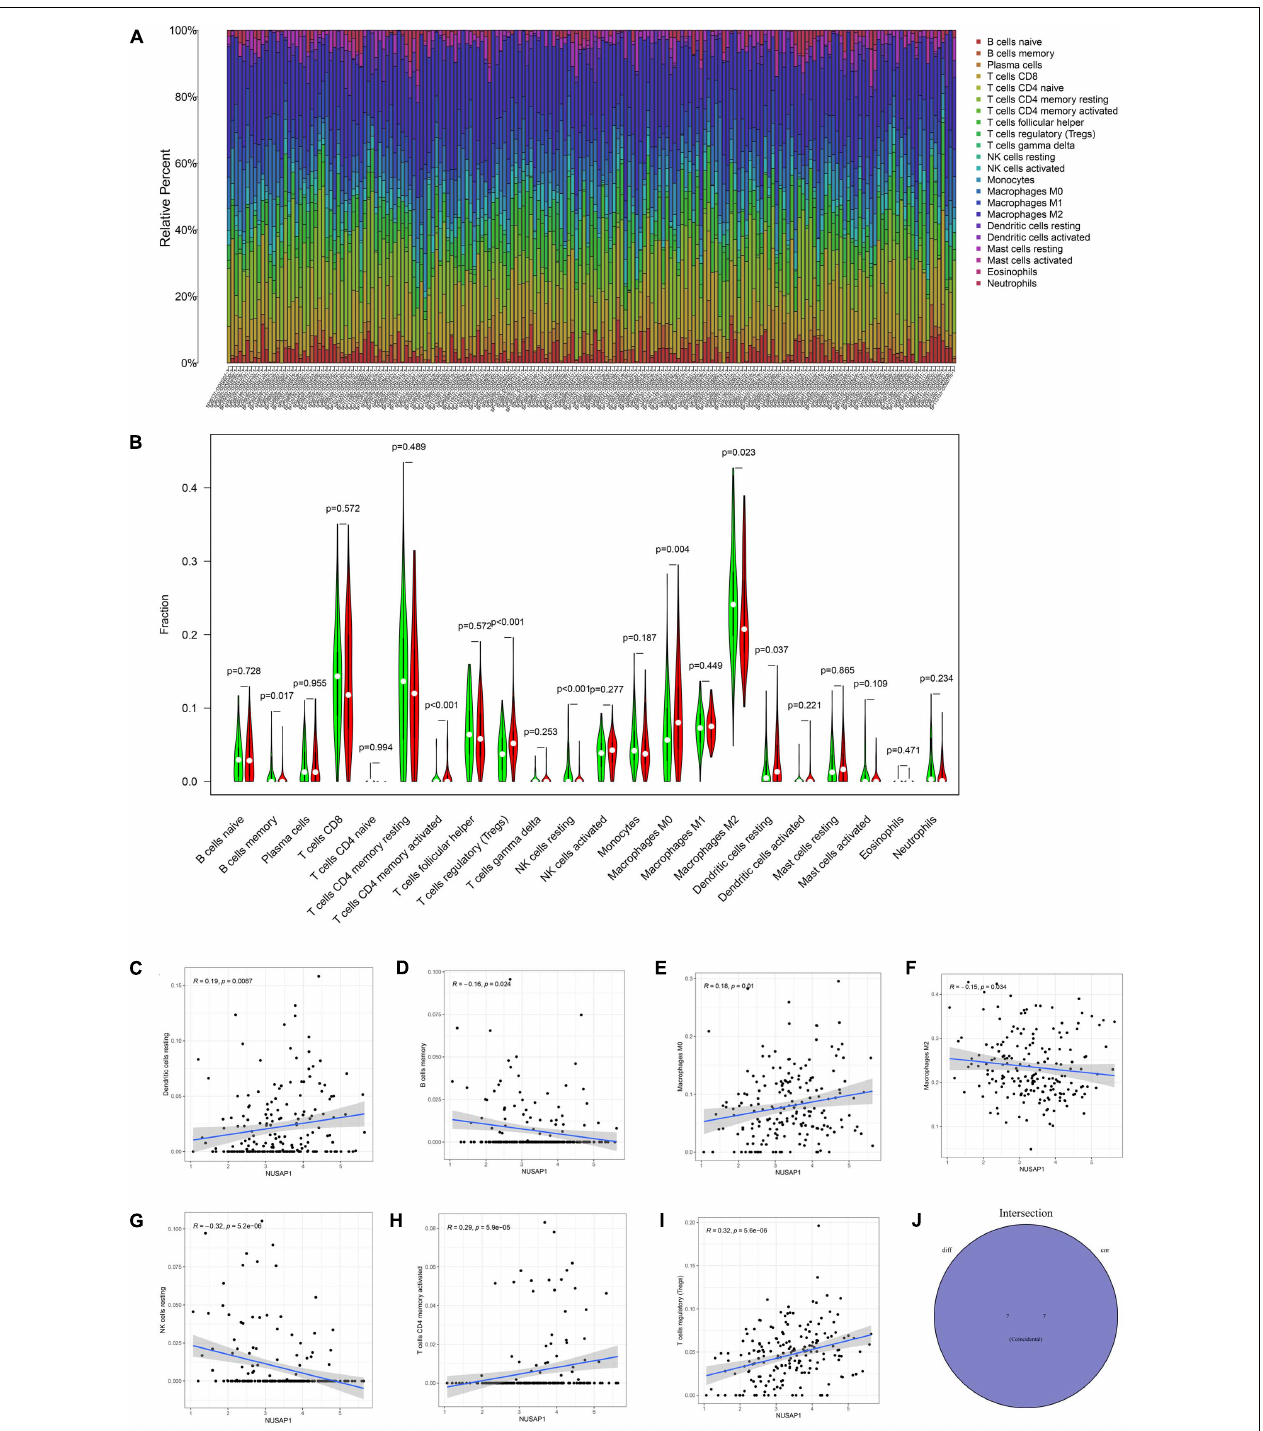
FIGURE 10 | Bar plot, violin plot, correlation diagrams, and Venn diagram. All pictures were drawn by HCC patients’ information in ICGC database. (A) Bar graph, which contained content of 22 immune cells in each sample. (B) Violin plot, which proved 22 immune cells whether they exhibited difference between high expression group and low expression group. (C) The correlation diagram between NUSAP1 and dendritic cells resting. (D) The correlation diagram between NUSAP1 and B cells memory. (E) The correlation diagram between NUSAP1 and macrophages M0. (F) The correlation diagram between NUSAP1 and macrophages M2. (G) The correlation diagram between NUSAP1 and NK cells resting. (H) The correlation diagram between NUSAP1 and T cells CD4 memory activated. (I) The correlation diagram between NUSAP1 and T cells regulatory (Tregs). (J) Venn diagram, which was used to visualize the immune cells that were both meaningful in violin plot and correlation